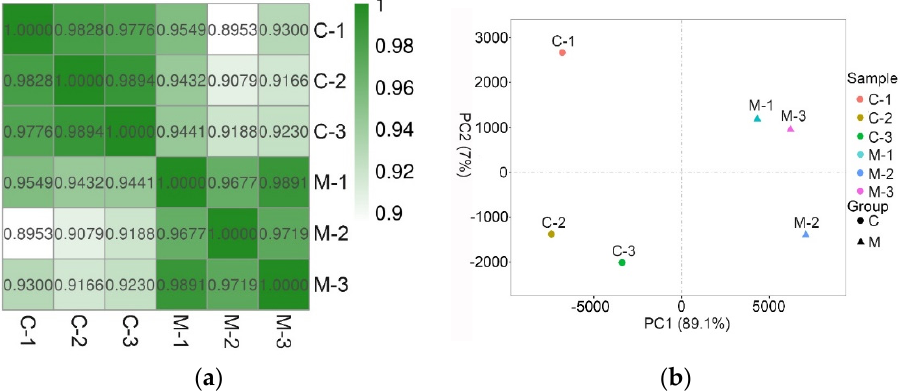
Figure 1. The correlation of samples. ( a ) Heatmap that shows the correlation coefficient among samples. The correlation of samples from the same groups was stronger than that from different groups; ( b ) Principal component analysis (PCA) of the six samples. PCA analysis showed that the samples in M group were more likely to cluster together, with a similar pattern in C group. See note for Table 1.